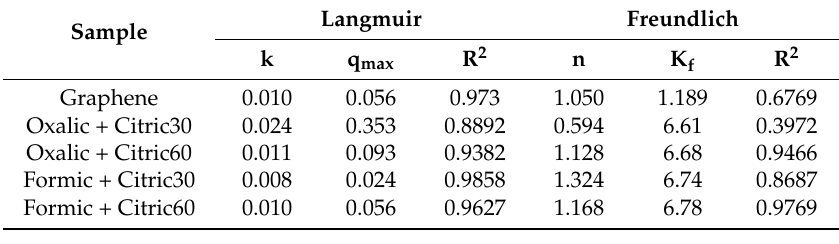
Table 3. Parameters of isotherms for urea adsorption, according with the Langmuir and Freundlich approach.